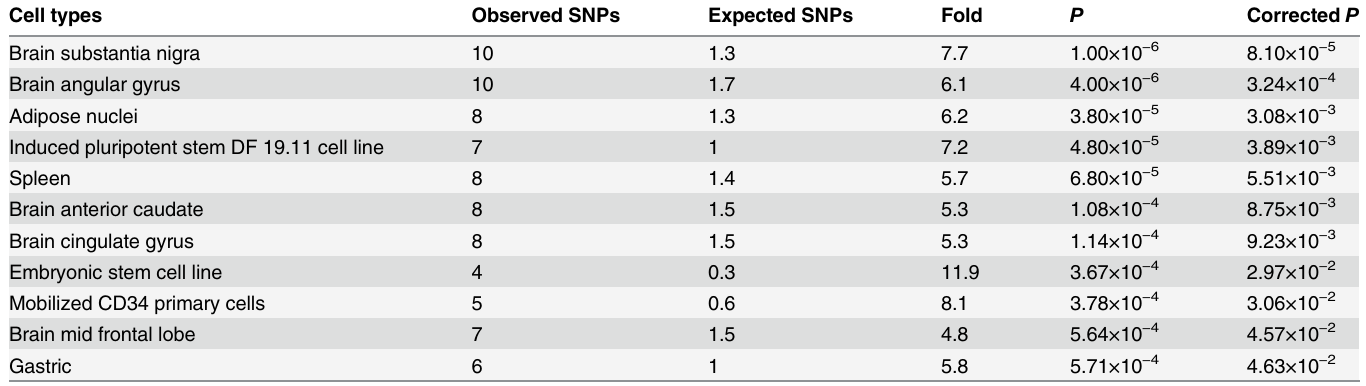
Table 2. Significant enrichment of 45 MI/CAD-associated SNPs in specific cell types detected by enrichment analysis. We examined whether 45 MI/ CAD-associated loci were enriched in regions of inferred strong enhancer chromatin states [27] in specific cell types using NIH Roadmap data and two mam- malian conservation algorithms, GERP and SiPhy-omega, implemented in HaploReg v2 [26]. We observed significant enrichment of MI/CAD-associated SNPs in specific cell types, including adipose nuclei, spleen and brain tissue. MI, myocardial infarction; CAD, coronary artery disease; SNP, single nucleotide